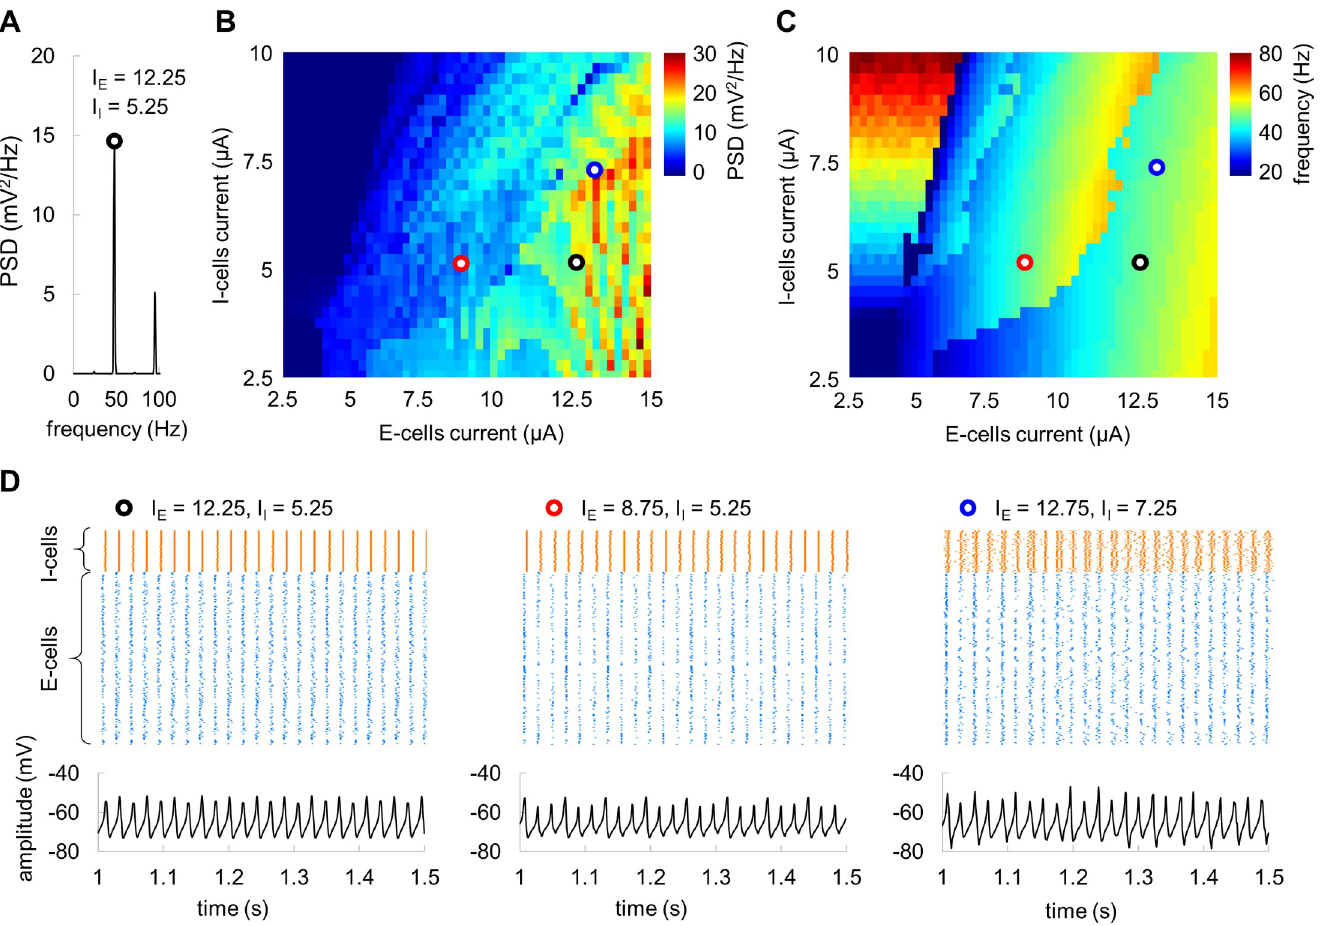
Fig 6. Model parameter space. (A) The PSD with spectral peak at 48 Hz for input currents I E = 12.25 μ A and I I = 5.25 μ A. (B, C) Power at the spectral peak (B) and corresponding frequency (C) of the network oscillations as a function of input current to E-cells and I-cells. Black, red, and blue circles indicate pairs of the currents producing oscillations at 48 Hz. (D) Spiking activity and corresponding average membrane potentials for three selected input currents that produce oscillations at 48 Hz.